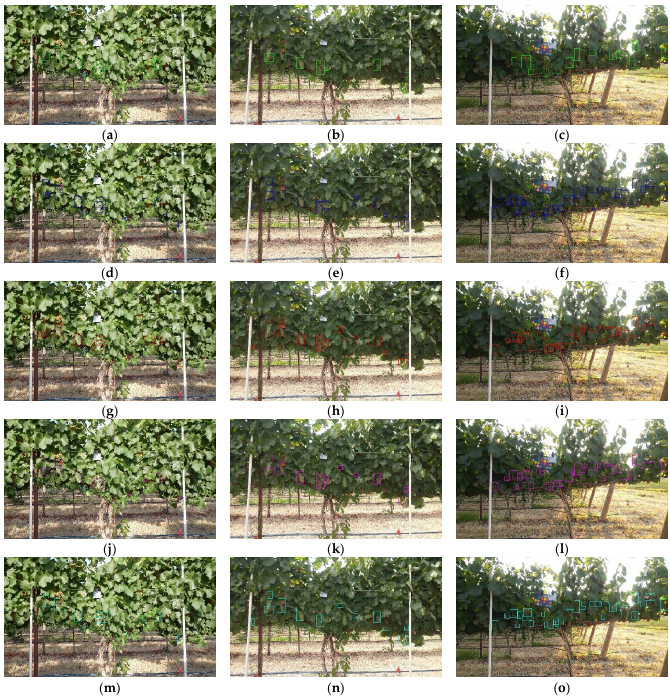
Figure A5. Demonstrations of detection results on the test set of Chardonnay (white variety) using ( a – c ) Faster R-CNN (bounding boxes in green color); ( d – f ) YOLOv3 (in blue color); ( g – i ) YOLOv4 (in red color); ( j – l ) YOLOv5 (in magenta color); and ( m – o ) Swin-transformer-YOLOv5 (in cyan color) under morning (left), noon (middle), and afternoon (right) sunlight directions/intensities.